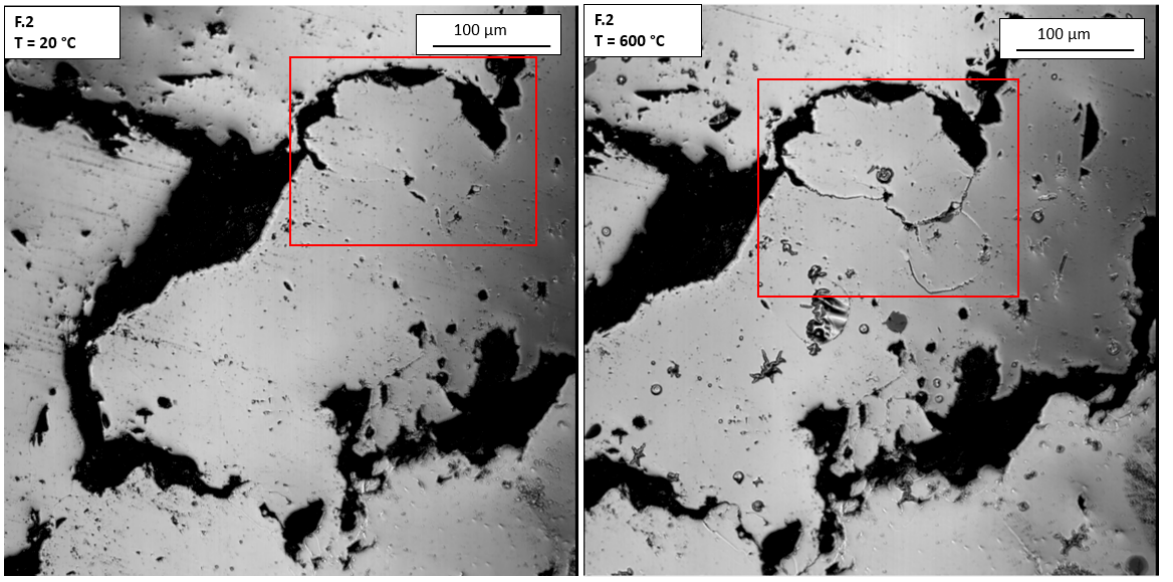
Figure 6. Images from high temperature confocal microscope (HTCM) experiment for F.2 at 20 °C and 600 °C, showing crack formation from an uneven SiO 2 surface. No impurity areas were found in this sample.